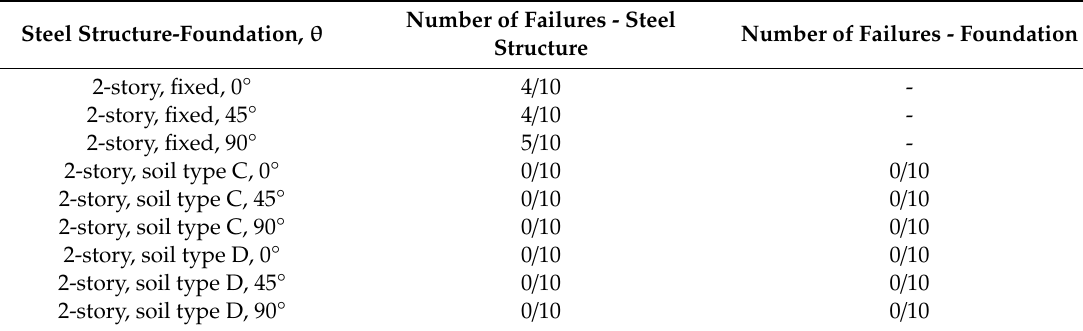
Table 5. The number of failures for the 2-story steel structure-foundation systems. Steel Structure-Foundation, θ